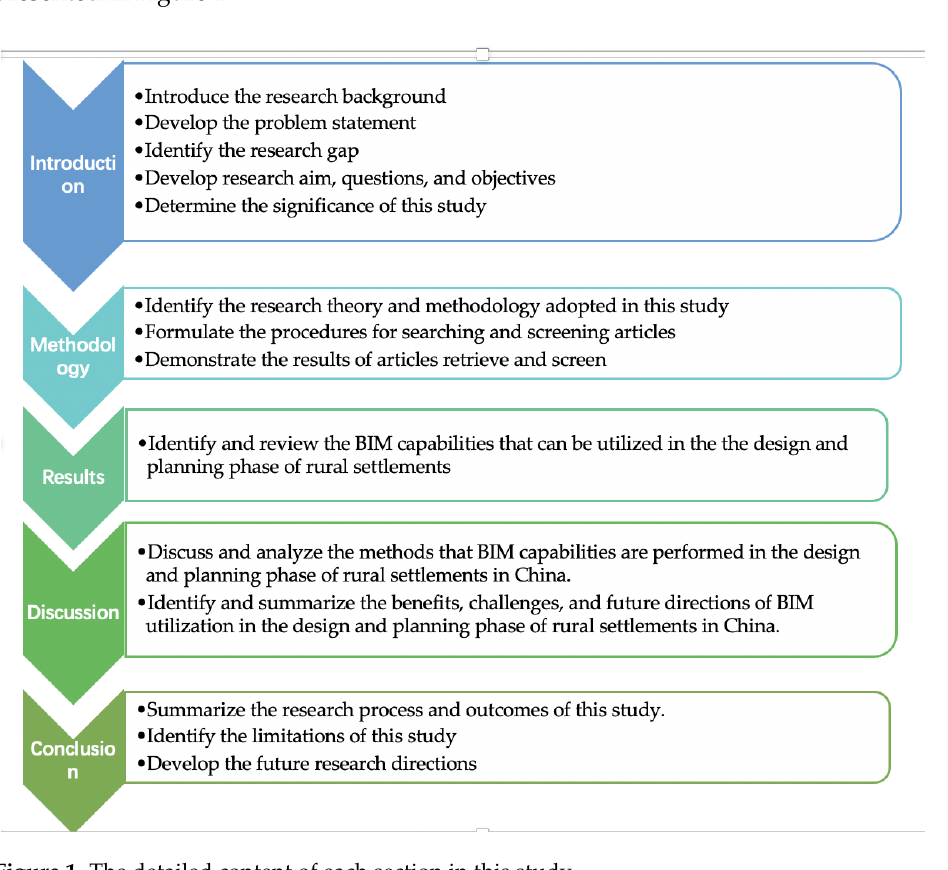
Figure 1. The detailed content of each section in this